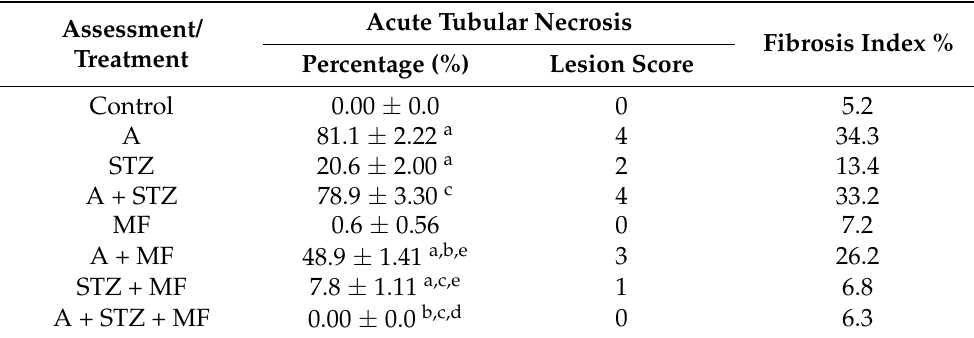
Table 6. Effect of metformin (MF) treatment on histopathological assessment of kidney sections in diabetic and non-diabetic rats with adenine (A)-induced chronic kidney disease